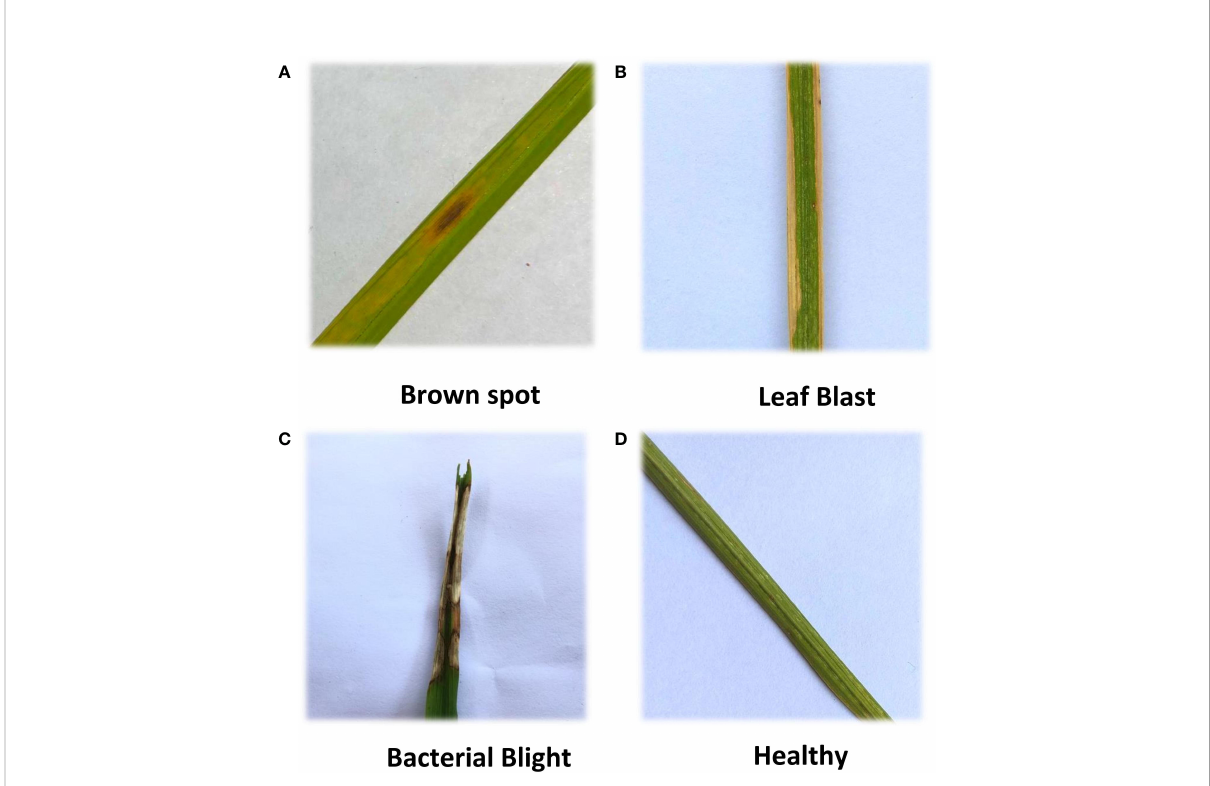
FIGURE 1 Four kinds of rice leaf images. (A) Brown spot, (B) Leaf Blast, (C) Bacterial Blight, (D) Healthy. Four kinds of rice leaf images showing different